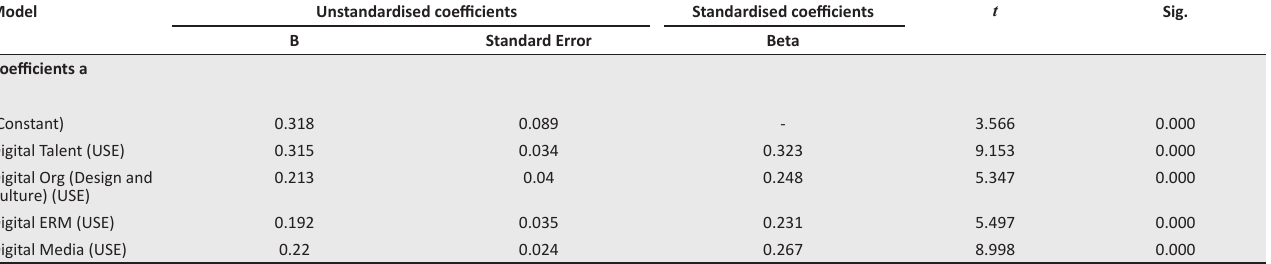
TABLE 5c: Regression analysis: Adoption of Digital Human Resource Management Strategies (USE) factors and Adoption of Digital Human Resource Management Strategies (CONTRIBUTION).